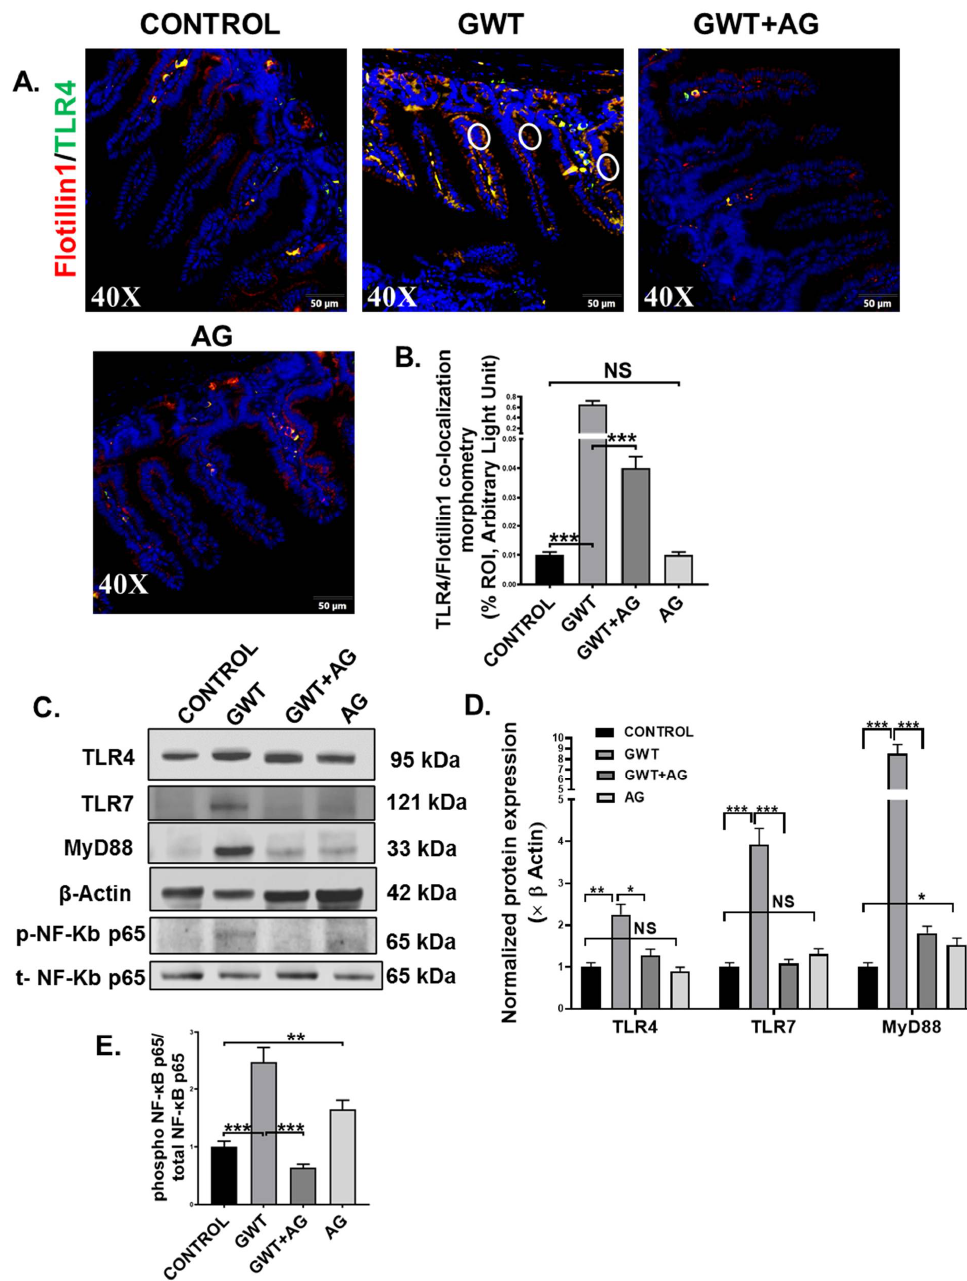
Figure 4. GW chemical-induced microbiome pattern alteration and gut leaching activate TLR4 and TLR7 pathways in the small intestine, leading to downstream inflammatory signaling activation. Representative immunofluorescence images depicting ( A ) Flotillin1 (red) and TLR4 (green) co-localization events in the small intestine, counterstained with DAPI (blue) of CONTROL, GWT, GWT+AG, and AG mice groups. Images were taken at 40× magnification. Co-localization was represented by the yellow dots and marked by white circles. ( B ) Morphometric analysis (calculated as %ROI) of Flotillin1-TLR4 co-localization events. Y -axis represents % positive immunoreactive area (% ROI) ( n = 3; mean value taken from three separate microscopic fields) (*** p < 0.001, NS: non-significant). ( C ) Western blot images of TLR4, TLR7, MyD88, β -actin, phospho-NF- κ B p65, and total-NF- κ B p65 protein expression level obtained from intestinal tissue lysates. Lanes 1–4 represent CONTROL, GWT, GWT+AG, and AG mice groups, respectively. Densitometry analyses of ( D ) TLR4, TLR7, MyD88 immunoblots normalized against β -actin, and ( E ) phospho-NF- κ B p65 immunoblot normalized against total-NF- κ B p65 (* p < 0.05, ** p < 0.01, *** p < 0.001, NS: non-significant). Data were represented as mean ± SEM and statistical significance was tested using unpaired t -test between the groups (* p < 0.05, ** p < 0.01, *** p < 0.001), followed by Bonferroni Dunn Post hoc